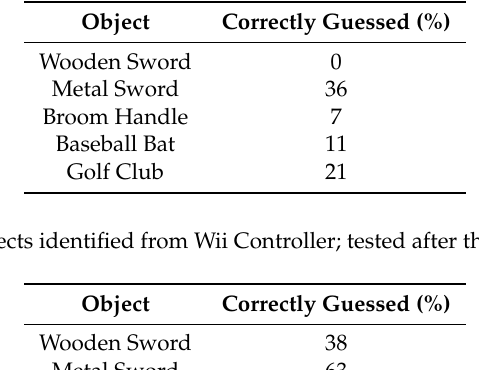
Table 9. Objects identified from the Wii Controller; tested before the listening test.